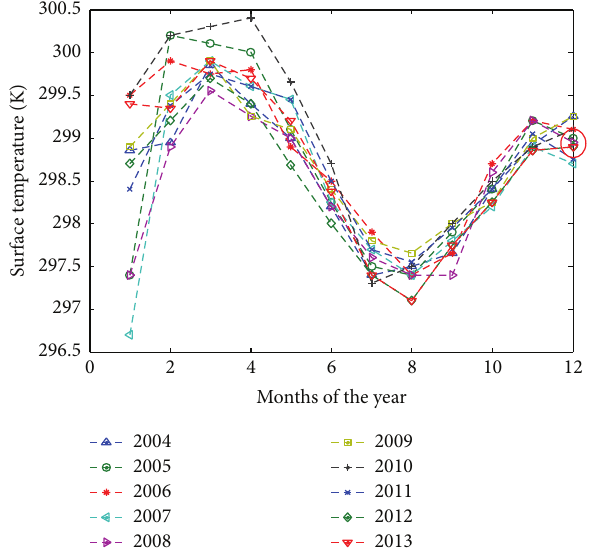
Figure 3: Monthly surface temperature data (2004–2013).